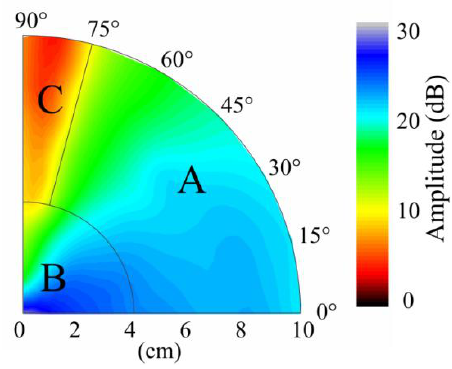
Figure 3. Sensitivity distribution properties of PS-FBG on an aluminum plate shown in logarithmic scale.